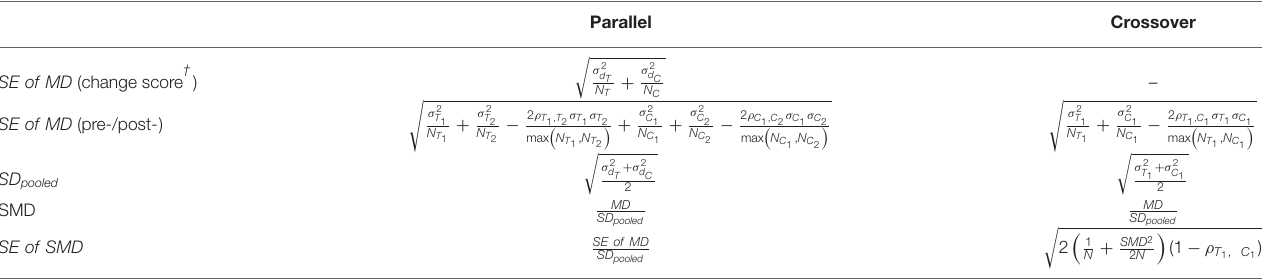
TABLE 2 | Calculation of the standard error (SE) of the mean difference (MD), the standardized mean difference (SMD), and the SE of SMD based on the type of study design (parallel vs. crossover randomized controlled trials). Parallel Crossover SE of MD (change score †